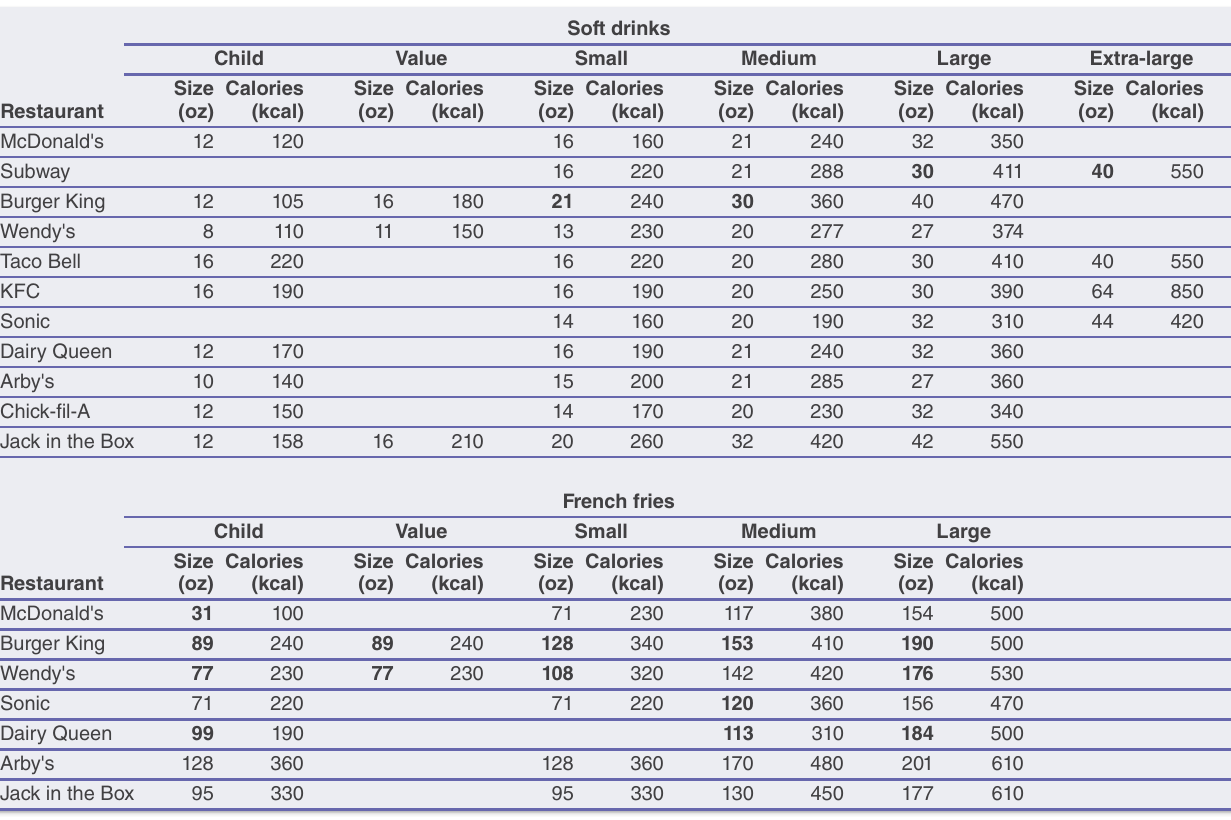
Table 15. Sizes of soft drinks and french fries by